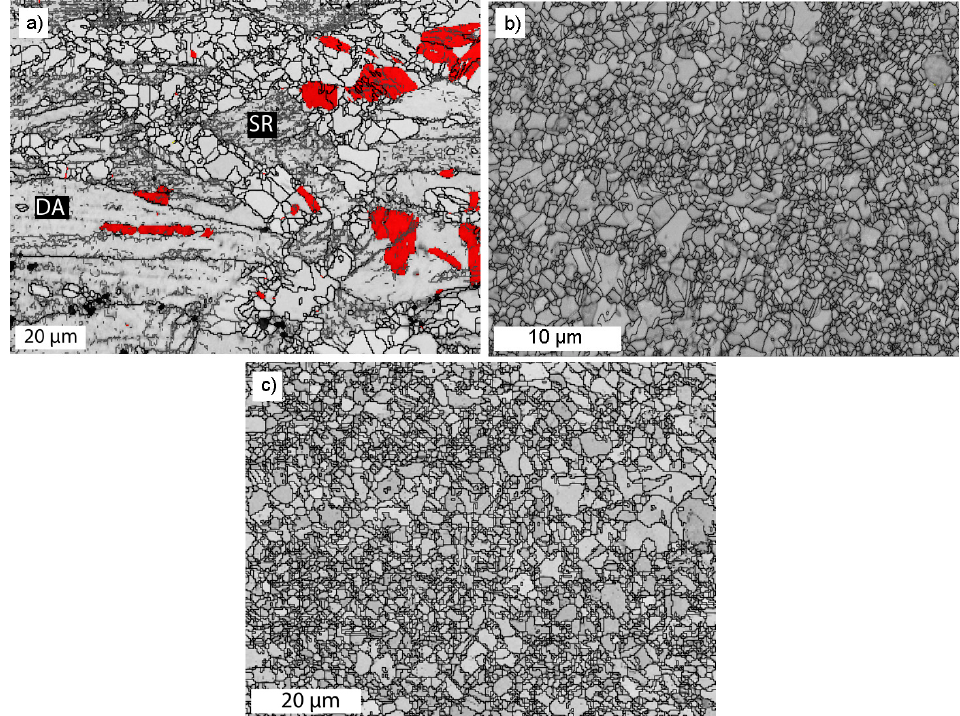
Figure 6. Examples of reversed microstructures in 301LN with various grain size. Partially reversed (32% cold rolling, 750 °C for 0.1 s) with shear reversed (SR) fine and medium-size grains, a large DA grain and retained DIM (red colored phase) ( a ) and diffusionally reversed ultrafine and medium-size grains in 63% cold-rolled steel, annealed at 800 °C for 1 s ( b ) and at 900 °C for 1 s ( c ).